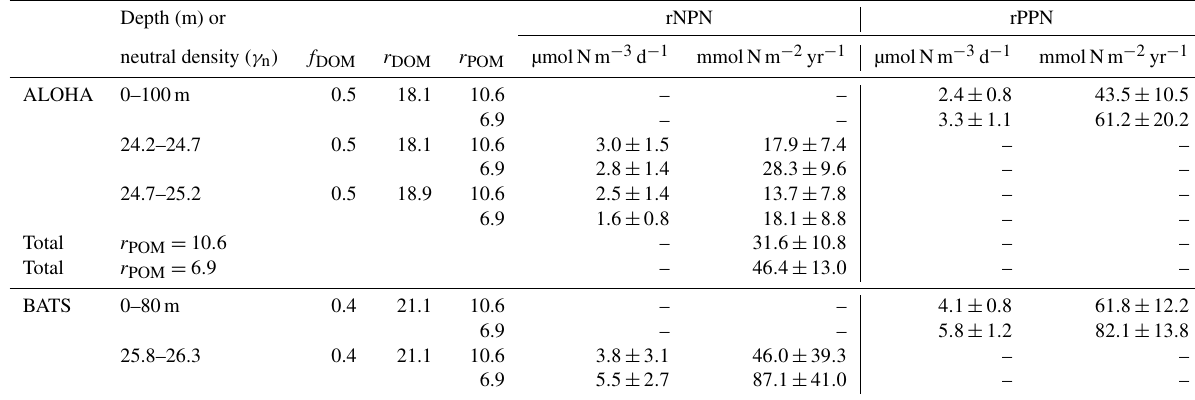
zone at the BATS station is estimated at 5 . 8 ± 1 . 2 and 4 . 1